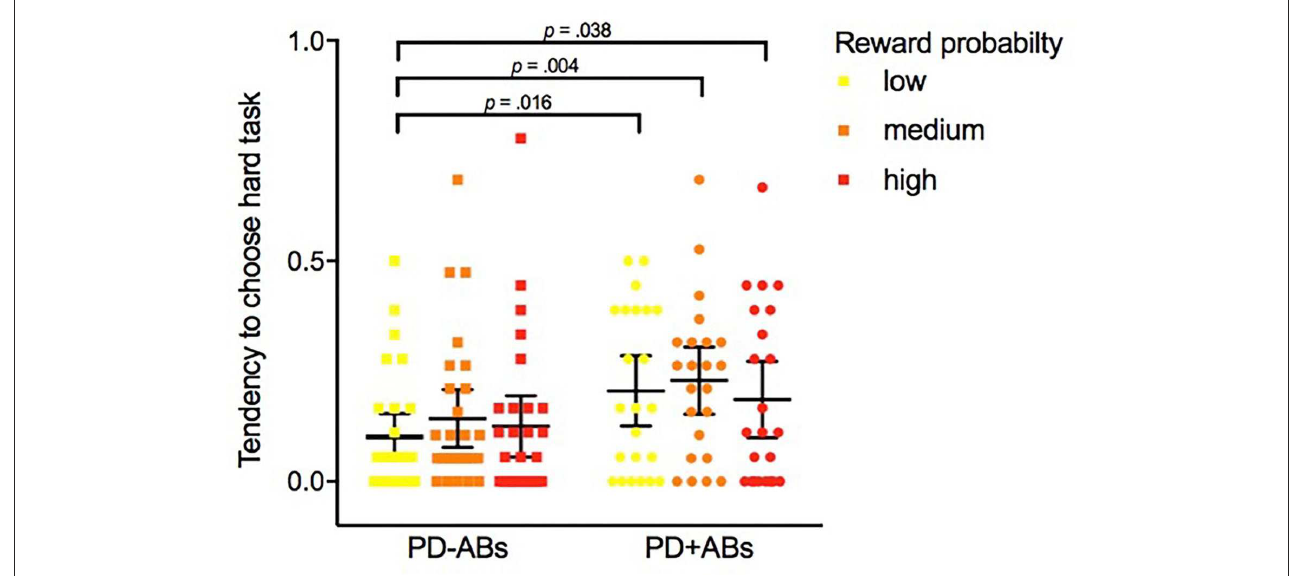
FIGURE1 Tendency average of PD-Abs and PD + ABs to choose the hard task on the Effort Expenditure for Rewards Task under different levels of reward probability: low (12%), medium (50%), and high (88%).